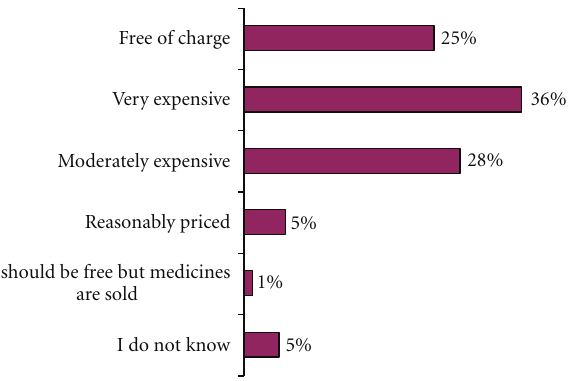
Figure 3: Perceived cost of TB services in Tajikistan (12%), people living with HIV (17%) and persons who have been in prison